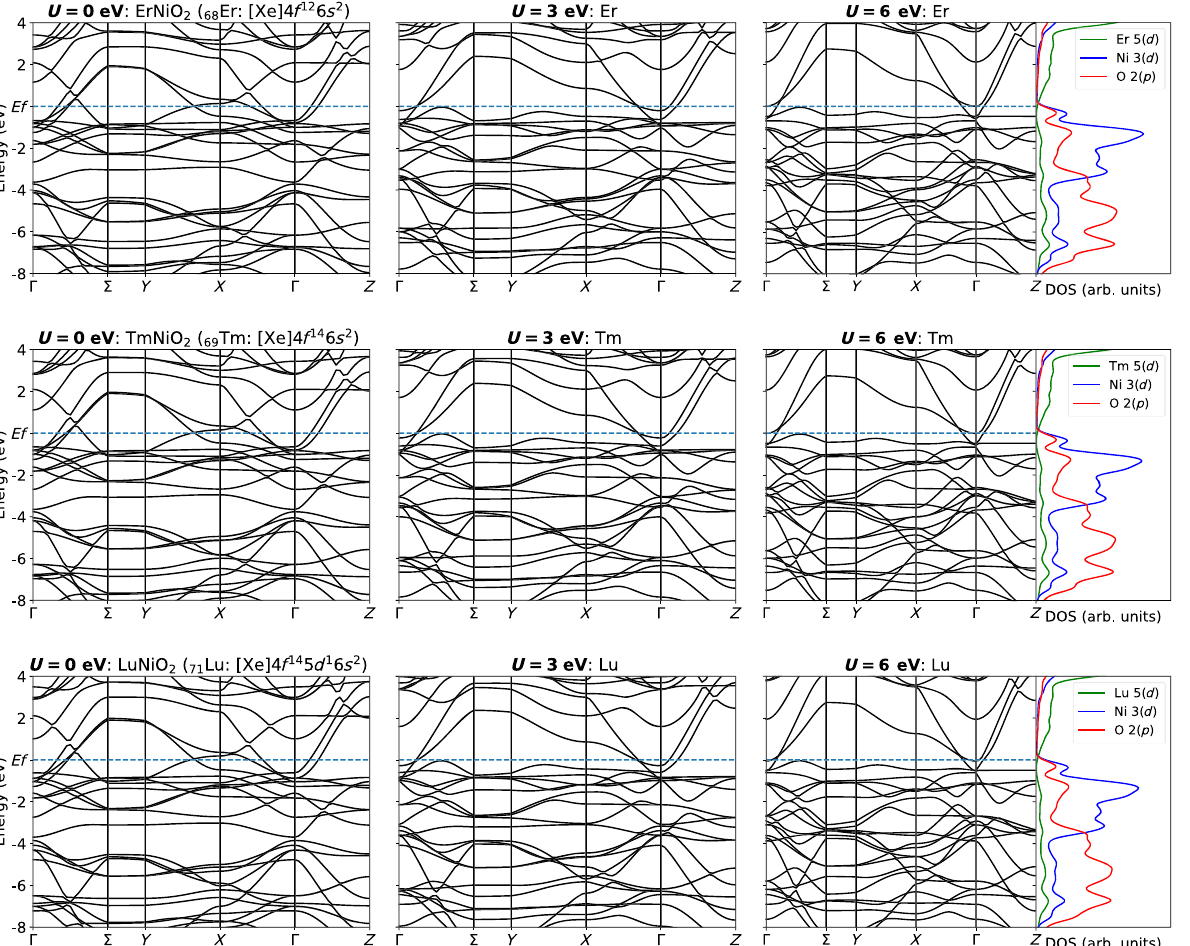
FIG. 6. Band structures of R NiO 2 calculated by GGA, GGA þ U ( U ¼ 3 eV), GGA þ U ( U ¼ 6 eV), and partial density of states of R NiO þ U (6 eV). 2 calculated by GGA